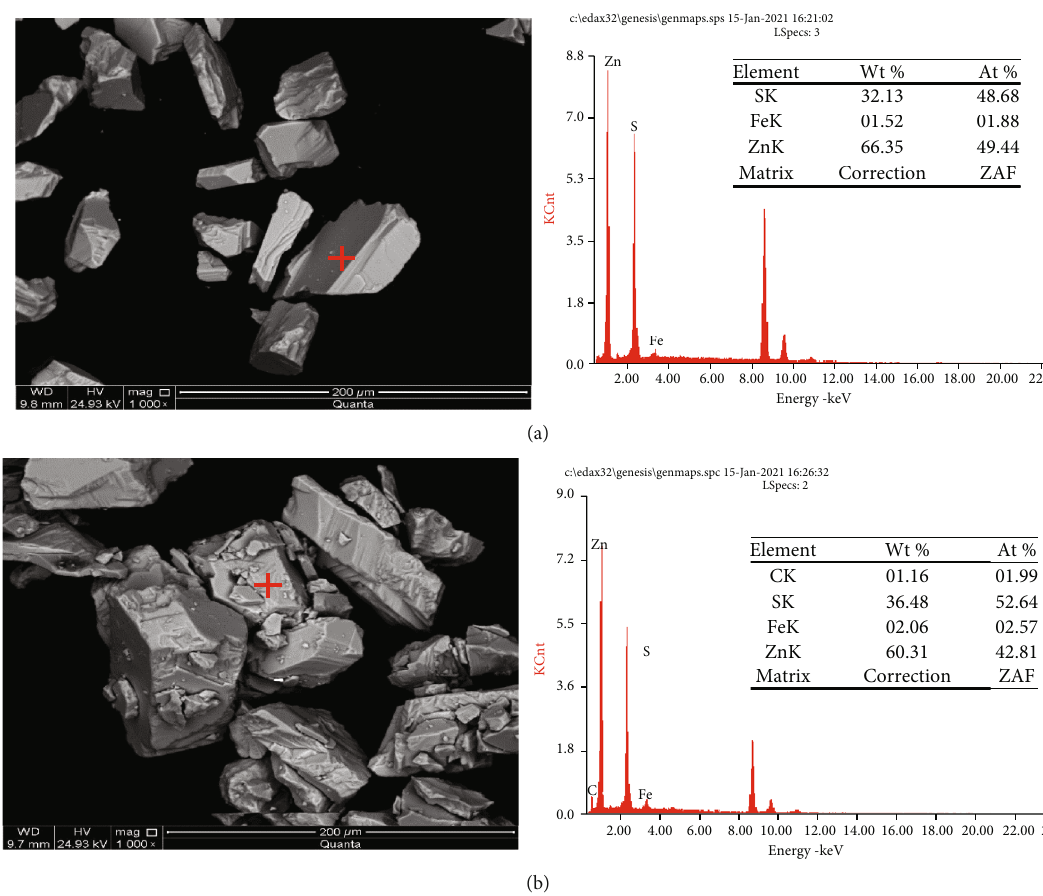
Figure 11: SEM-EDS images of sphalerite treated with TO: (a) without the addition of TO; (b) with the addition of 10mg/L TO.